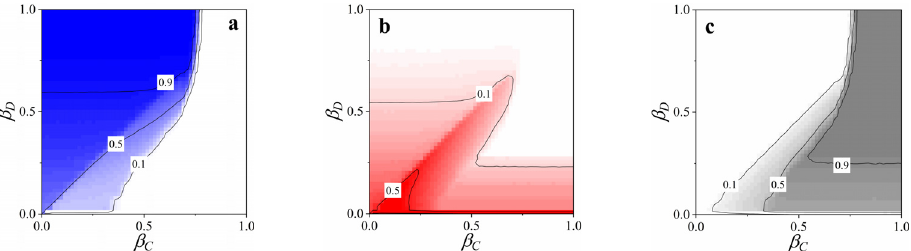
Figure 7. Fraction of ( a ) cooperators (blue), ( b ) defectors (red), and ( c ) loners (gray) as a function of cooperators’ and defectors’ greediness ( β C and β D ). The other parameters are r = 3.5, ω C = ω D = 0.02, γ + = γ − = 0.5, λ = 2, and M = 100.